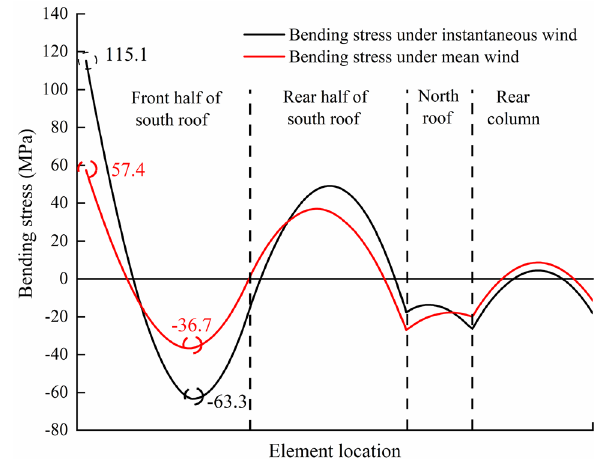
Figure 11. Bending stress distribution of the 16th arch from East.